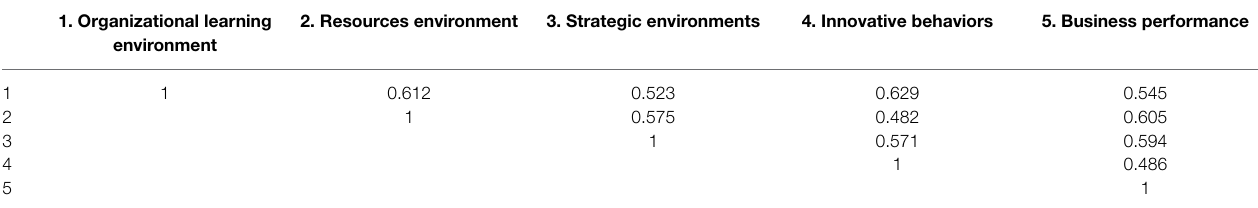
TABLE 2 | Correlation coefficient table of each variable.